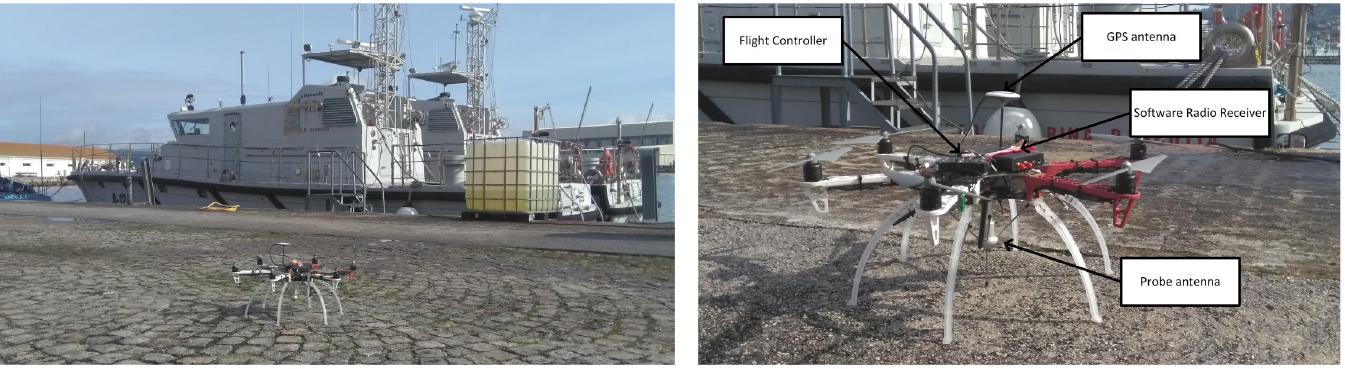
Fig 20. UAV carrying the proposed measurement system: Vertical antenna and software radio